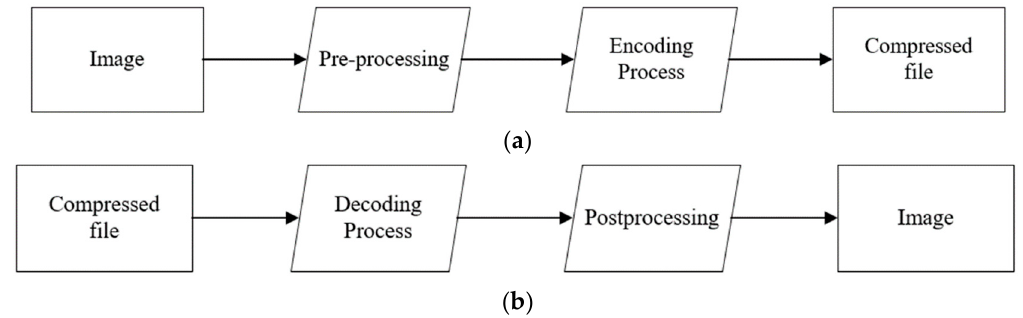
Figure 5. Image compression system. ( a ) Compression process. ( b ) Decompression process.